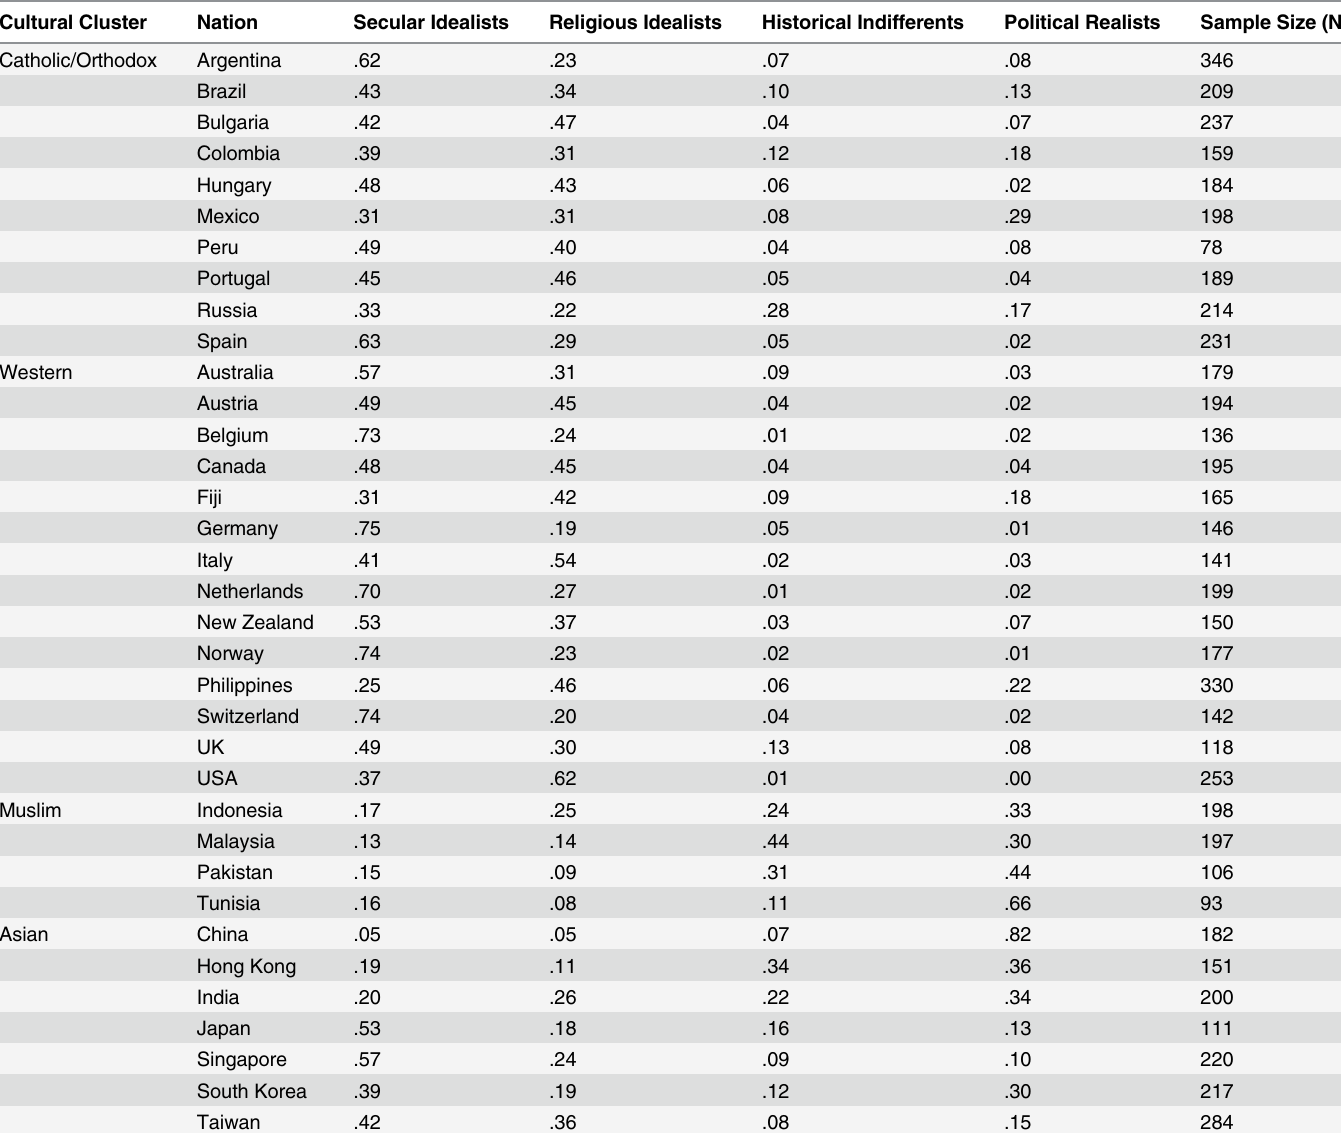
Table 2. Proportion of sample classi fi ed as belonging to each representational pro fi le by nation and by cultural cluster. Cultural Cluster Nation Secular Idealists Religious Idealists Historical Indifferents Political Realists Sample Size (N) .62 .23 .07 .08 346 .43 .34 .10 .13 209 .42 .47 .04 .07 237 .39 .31 .12 .18 159 .48 .43 .06 .02 184 Mexico .31 .31 .08 .29 198 .49 .40 .04 .08 78 .45 .46 .05 .04 189 .33 .22 .28 .17 214 .63 .29 .05 .02 231 Western .57 .31 .09 .03 179 .49 .45 .04 .02 194 .73 .24 .01 .02 136 .48 .45 .04 .04 195 .31 .42 .09 .18 165 .75 .19 .05 .01 146 .41 .54 .02 .03 141 .70 .27 .01 .02 199 New Zealand .53 .37 .03 .07 150 .74 .23 .02 .01 177 .25 .46 .06 .22 330 .74 .20 .04 .02 142 .49 .30 .13 .08 118 .37 .62 .01 .00 253 .17 .25 .24 .33 198 .13 197 .15 .09 .05 182 Hong